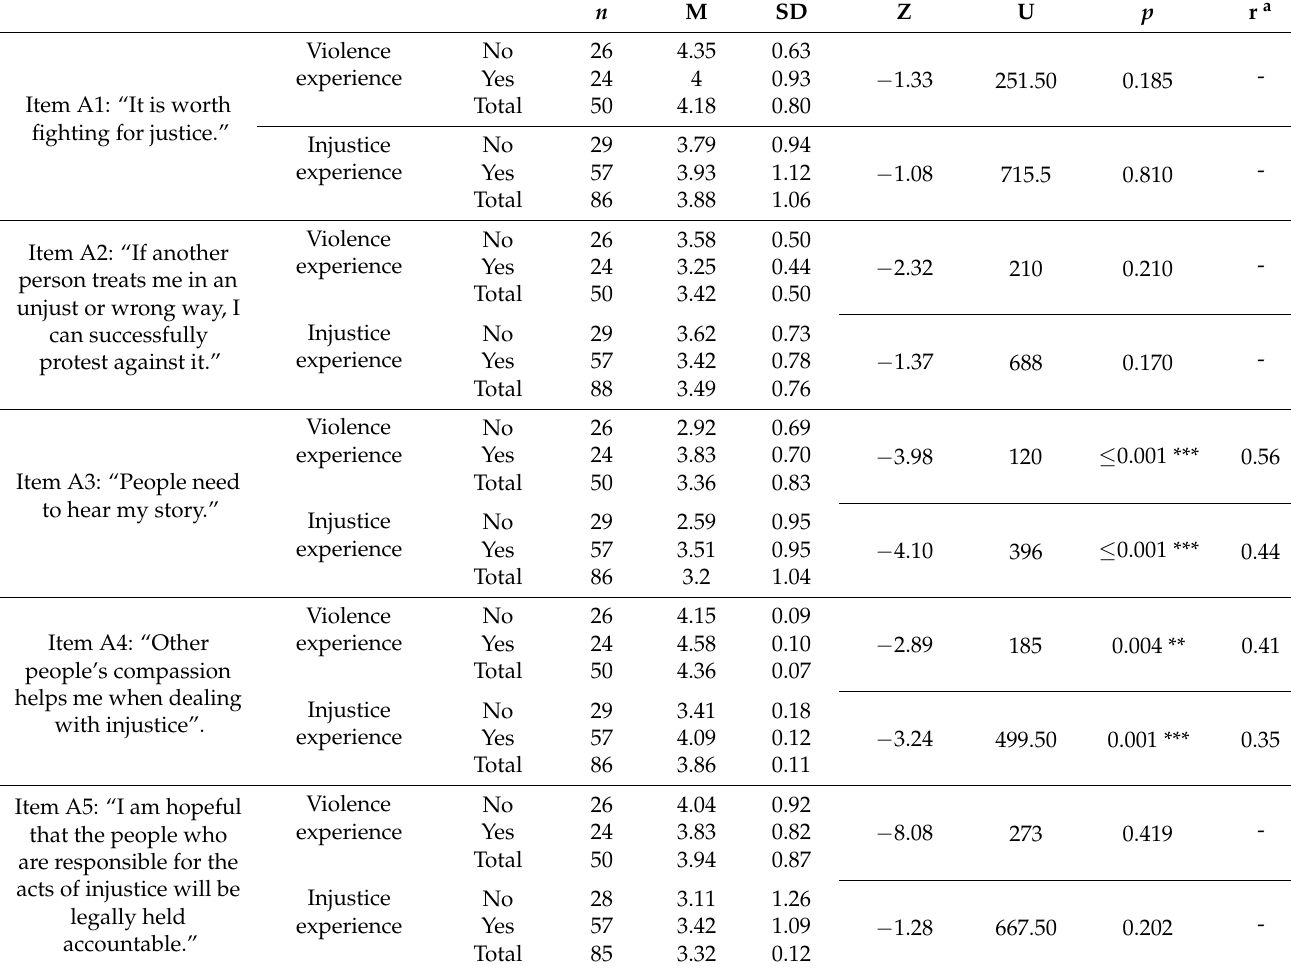
Table 4. Mann–Whitney U test tables of additional